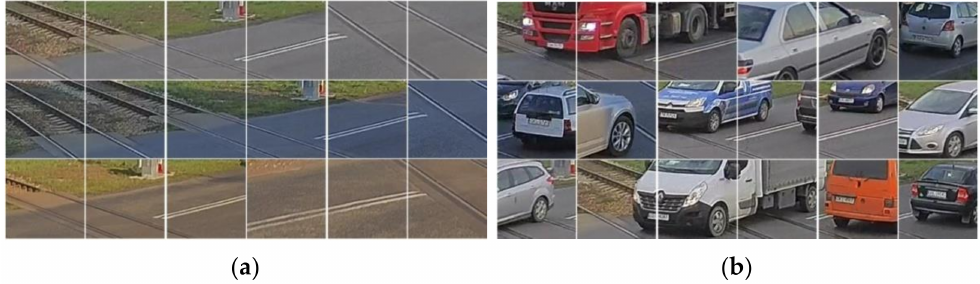
Figure 3. Square patches used for training and testing CNNs: ( a ) empty squares, ( b ) squares with objects or parts of